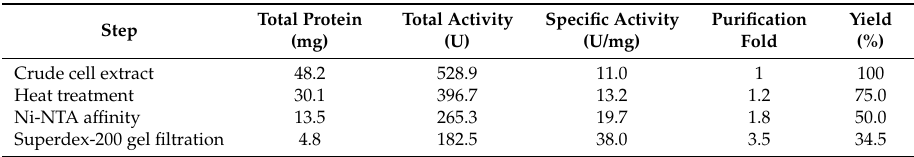
Figure 3. Temperature optima ( A ) and pH optima of the r ‐ Ao FT( B ). ( A ) Temperature optima of r ‐ Ao FT was determined with sucrose and glucose 6 ‐ acetate as substrates in 50 mM sodium acetate buffer (pH 5.5) at temperatures ranging from 30 °C to 80 °C; ( B ) pH optima of the enzyme at pHs ranging from 3.5 to 8.0 was measured for 24 h at 55 °C. The buffers used were 50 mM of sodium citrate